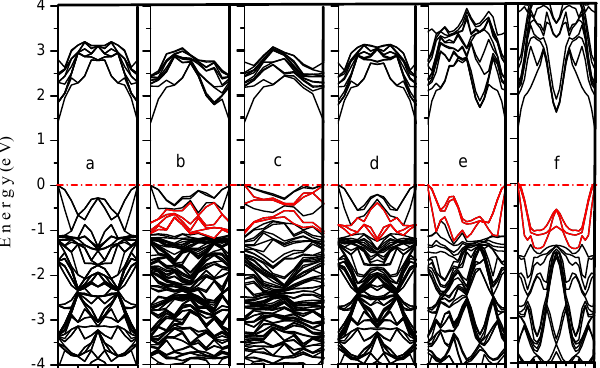
Figure 1. The band structure of GaAs ( d ) x = 3.1%; ( e ) x = 6.3%; ( f ) x =